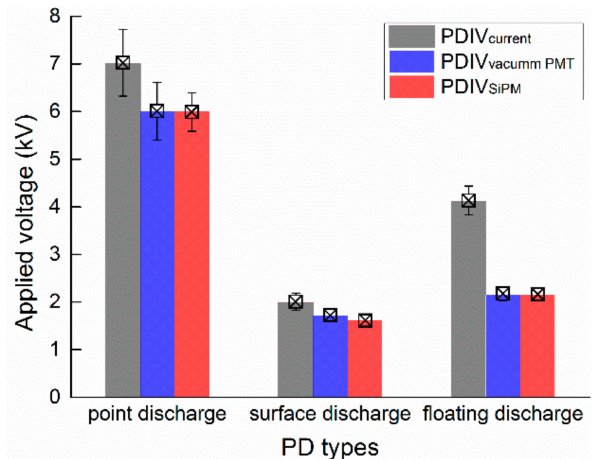
Figure 7. Partial-discharge inception voltages (PDIVs) of different defect models identified by SiPM, photomultiplier tube (PMT), and current pulse detections. The applied over-voltages on SiPM and PMT are 2.5 V and 800 V, respectively. The noise level of the current pulse detection in the laboratory condition is below 2 pC. The operating ambient temperature is approximately 25 ◦